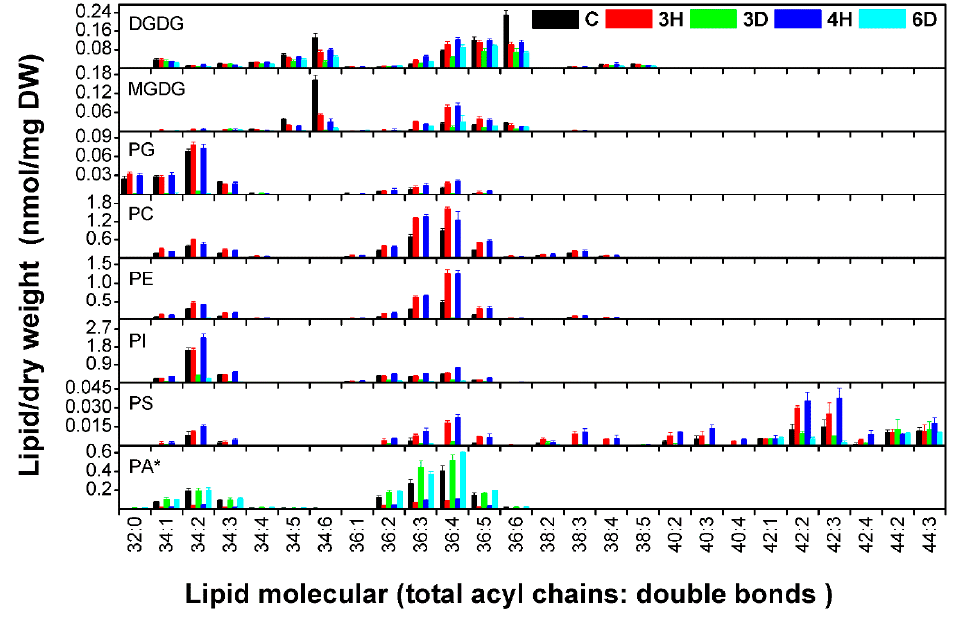
Figure 6. Molecular species contents of A. thaliana seeds during the hydration–dehydration cycles. The treatment was the same as that described in Figure 3. DW, dry weight. Each value is mean ± SD ( n = 4 or 5). * The PA contents were published previously [34].